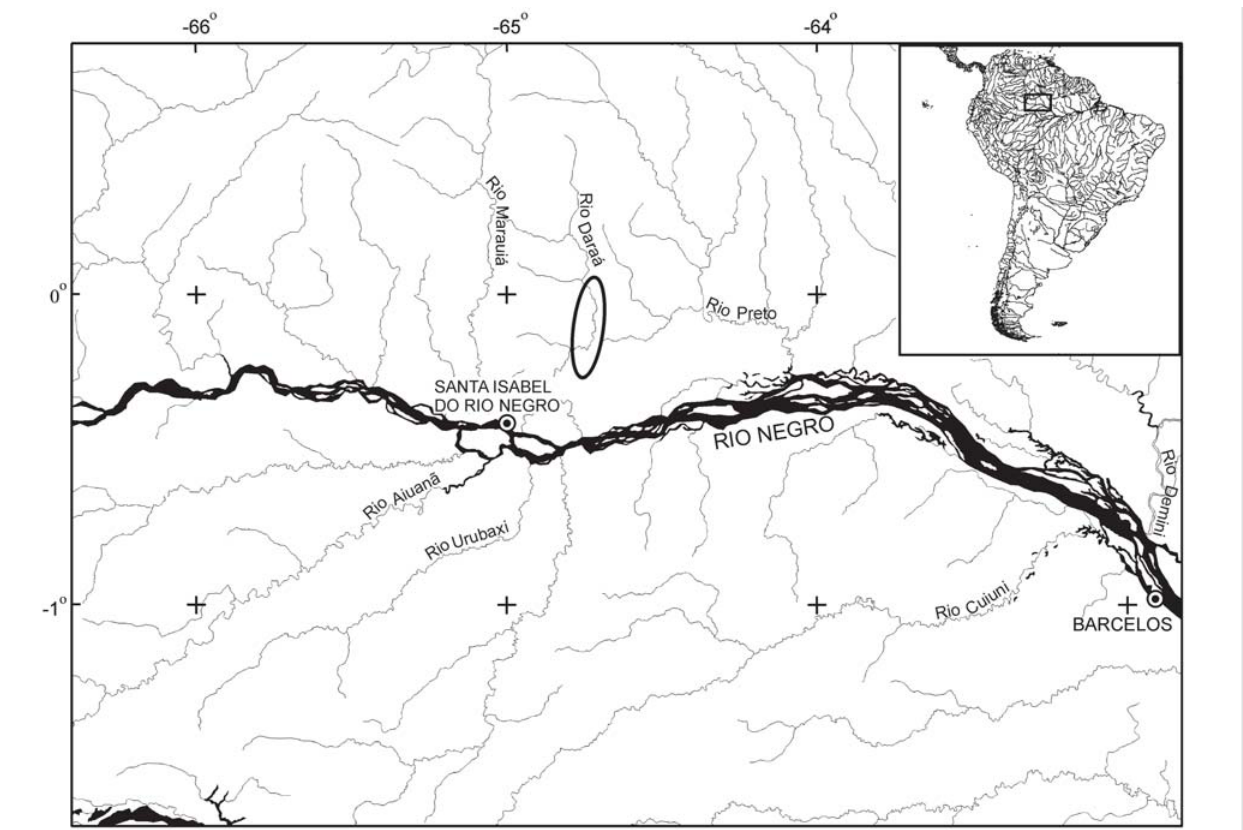
Fig. 4. Type locality of Rineloricaria daraha , rio Daraá, Amazonas,